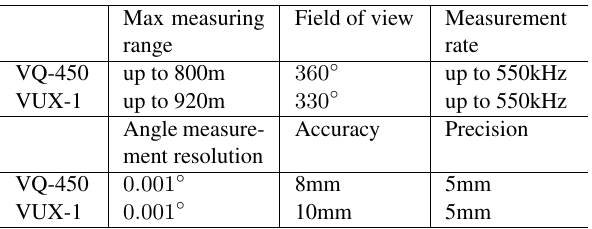
Table 1: RIEGL laser scanner